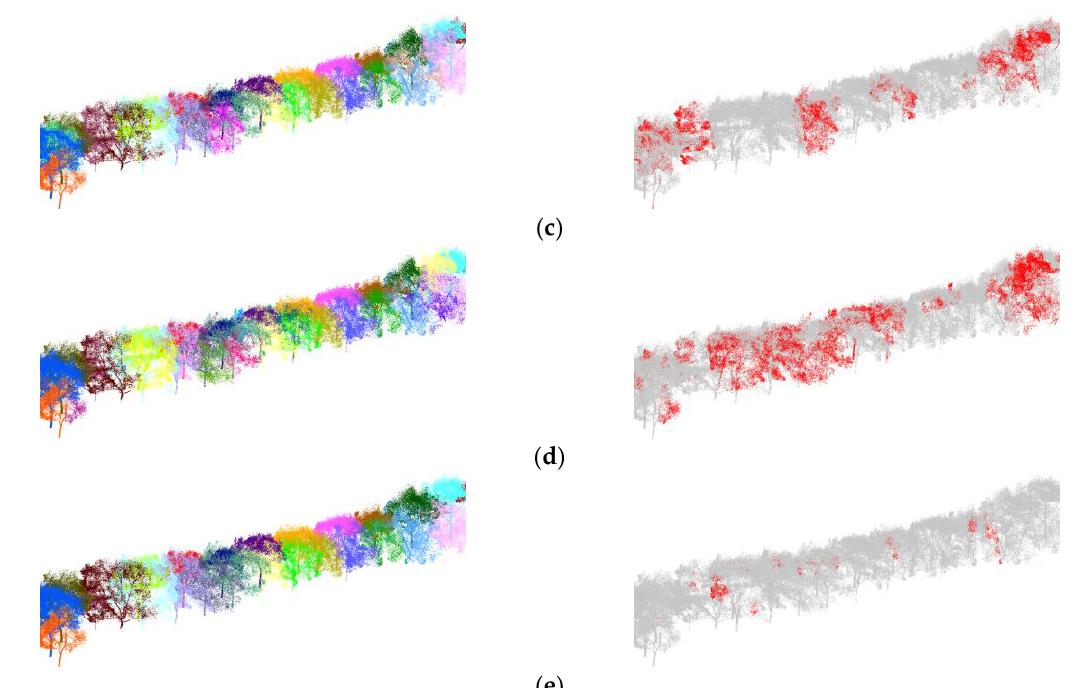
Figure 10. Individual tree segmentation results with different methods. Left: individual tree seg- mentation results; right: the error map of different results. (a) Individual tree segmentation result of watershed-based method [80], (b) individual tree segmentation result of mean shift-based method [81], (c) individual tree segmentation result of SGE_Net [64], (d) individual tree segmentation result of DAE_Net [67], (e) individual tree segmentation result of the proposed method.